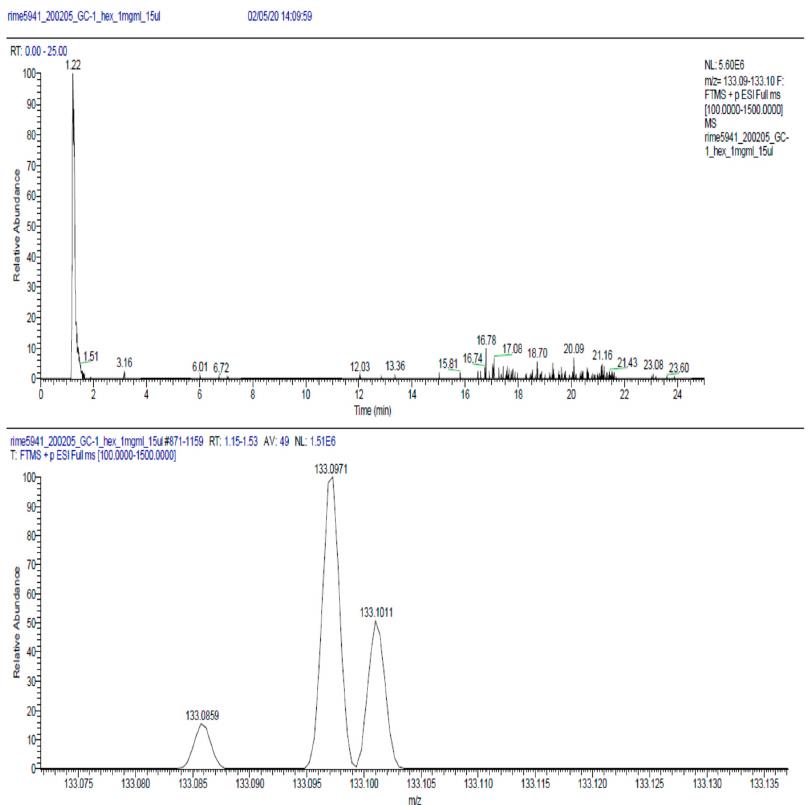
Figure A2. UPLC-MS analysis of the n -hexane extract of G. cambogia indicating the presence of hydroxycitric acid. Molecules 2020 , 25 , x